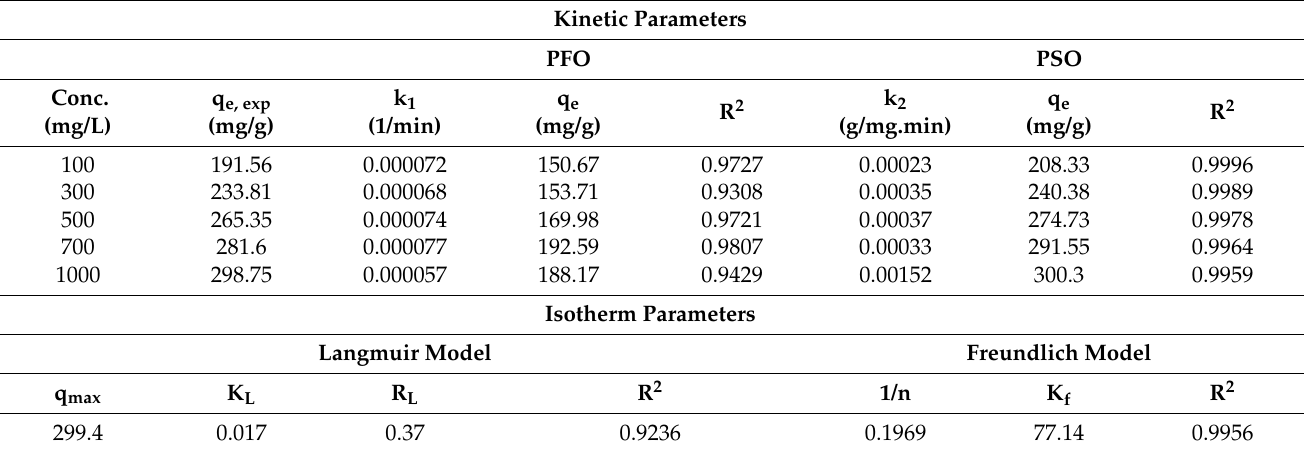
Table 2. Kinetic and isothermal parameters of the adsorption. Kinetic